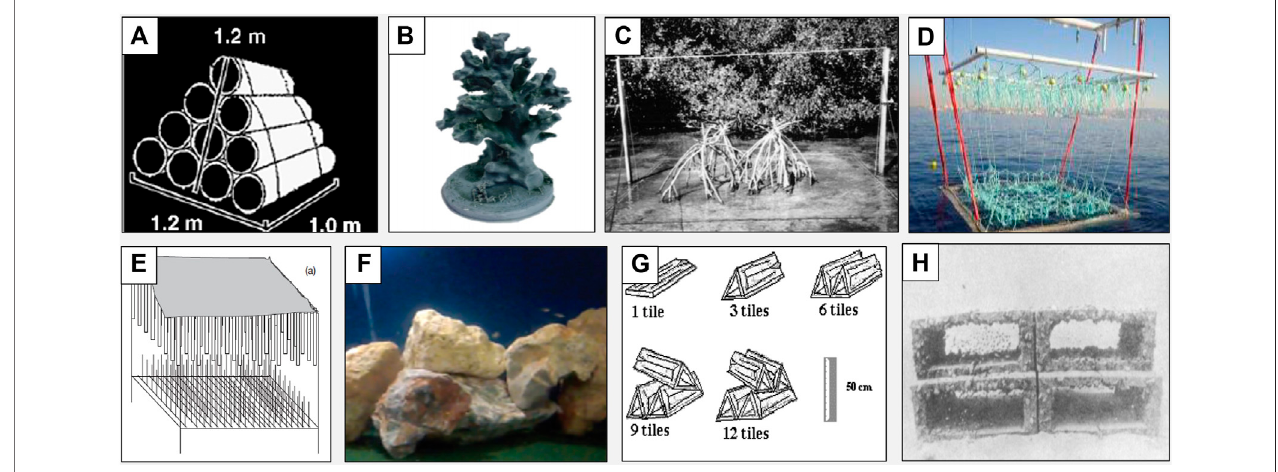
FIGURE2| Awidevarietyofmaterialsandcon fi gurationshavebeenusedtocreatearti fi cialhabitatmodulesinaquaticenvironments.Hereweillustrateexamplesof materials and their common designs presented in Table 2 . (A) A plastic PVC pyramid simulating freshwater reservoir habitat (Santos et al., 2011), (B) 3D printed plastic module(Plasticpolylacticacid fi lament)simulatingcoralspecies(RuhlandDixson,2019) (C) Mangroveproprootbundlessimulatingcomplexmangrovehabitat(Ellisand Bell, 2004), (D) Line “ fl oating rope ” structures simulating restored Posidonia oceanica (Neptune grass) beds (Charbonnel et al., 2011) (E) Plastic PVC pipe and metal iron rodsmodule simulatingmangroveroots and seagrass leaves, respectively (Verweij et al., 2006) (F) Rocks/rubble simulatingcoastal nursery habitat (Mercader et al., 2019) (G) Ceramic tiles simulating coastal habitat (Brotto and Araujo, 2001) (H) Concrete blocks with varying hole sizes simulating coral reefs (Talbot et al., 1978)